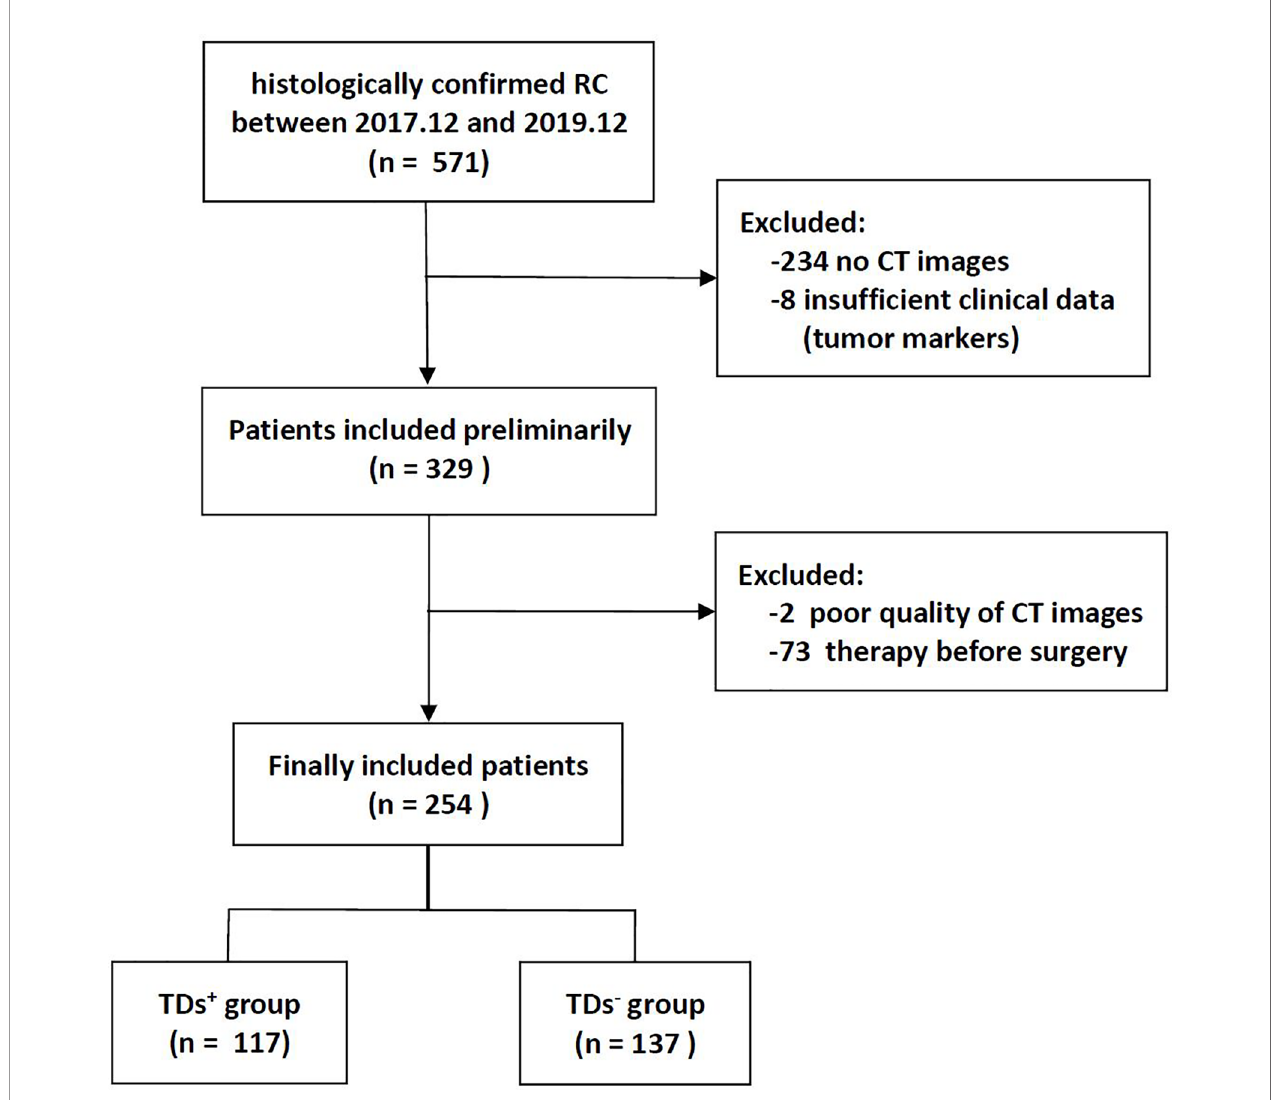
FIGURE 1 | Flowchart of patients ’ recruitment